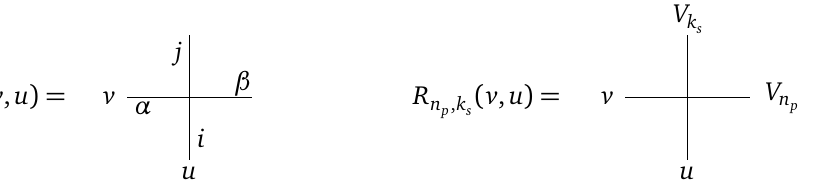
Figure 1: R -matrix as a vertex. Horizontal edge is associated with the parameter v and the space V . Vertical edge is associated with the parameter u and the space V n p